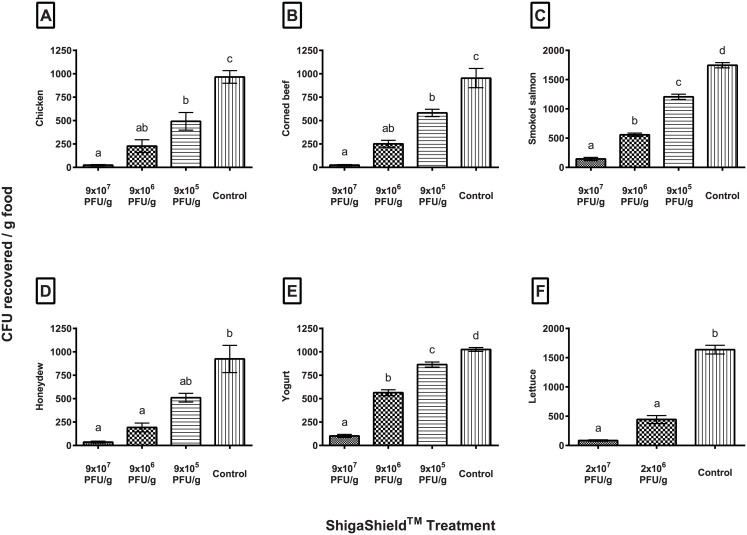
Effect of ShigaShield on the Shigella levels in various foods.Mean CFU recovered per gram of food (±SEM); for each food, means with different letters are significantly different (P<0.01). P-values are based on Tukey-Kramer multiple comparison post-hoc tests.